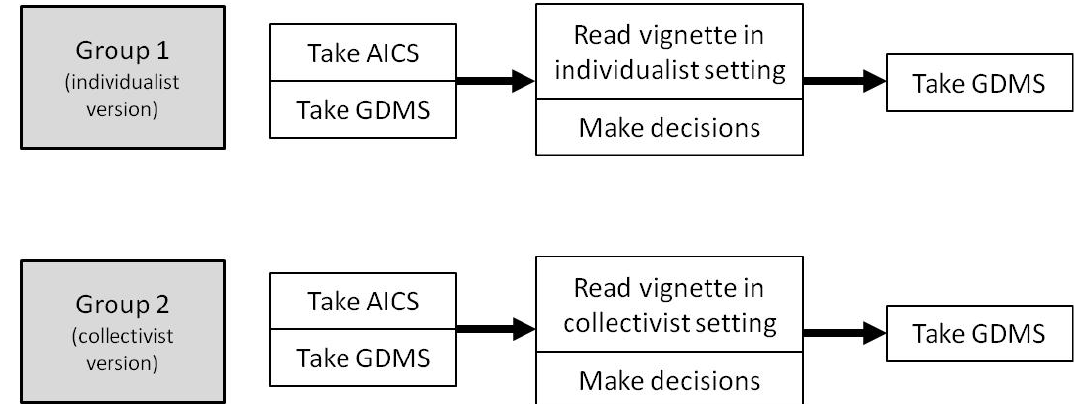
Figure 3. Experimental